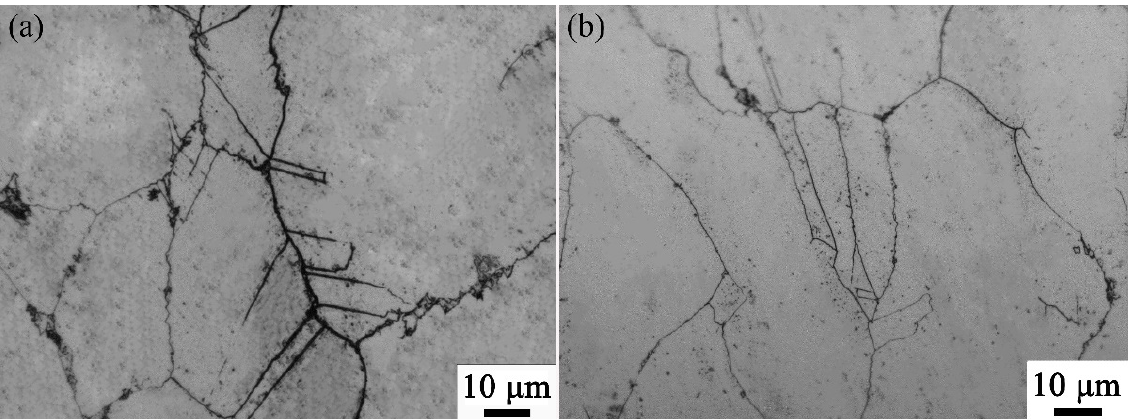
Figure 16. Microstructures of the bimetallic specimens compressed at 1150 °C, 5 s − 1 ( a ) and 1050 °C, 5 s − 1 ( b ).